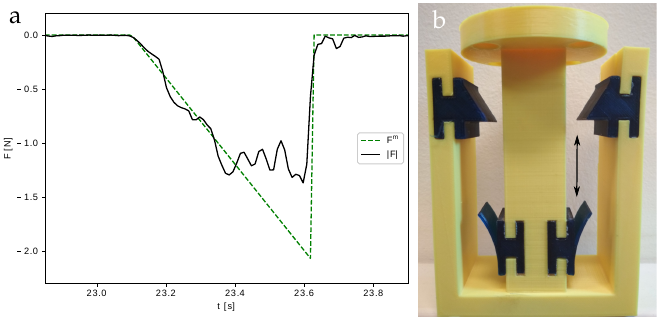
Figure 21. Forces ( F ) measured during plug insertion experiment and its predicate values ( F m ) ( a ); photo of plug and socket pair used during the experiment ( b